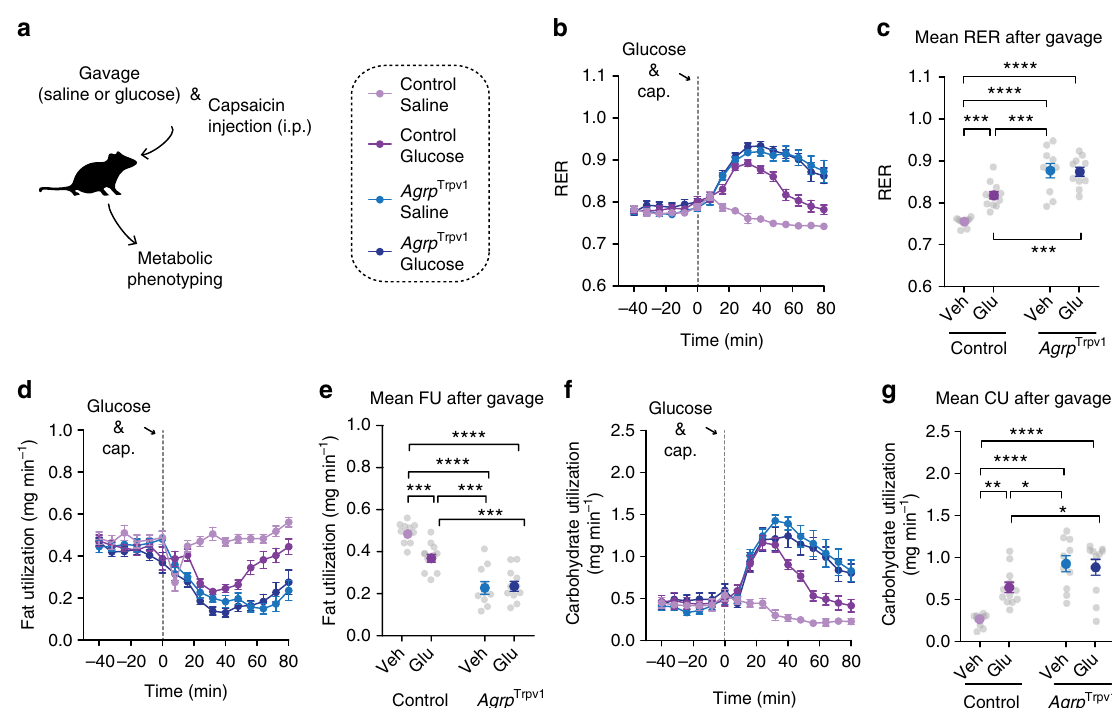
Fig. 2 Glucose ingestion and Agrp neurons control substrate utilization independently. a Control and Agrp Trpv1 mice received a bolus of saline or glucose (2 g kg − 1 ) via gavage followed by peripheral injection of capsaicin (10 mg kg − 1 , intraperitoneal (i.p.)). b Respiratory exchange ratio (RER). c Mean RER after gavage (interaction: F 1,40 = 9.82, P = 0.003; gavage solution: F 1,40 = 8.20, P = 0.006; genotype: F 1,40 = 71.31, P < 0.0001). d Fat utilization. e Mean fat utilization after gavage (interaction: F 1,40 = 7.91, P = 0.007; gavage solution: F 1,40 = 6.07, P = 0.01; genotype: F 1,40 = 79.82, P < 0.0001). f Carbohydrate utilization. g Mean carbohydrate utilization after gavage (interaction: F 1,40 = 8.29, P = 0.006; gavage solution: F 140 = 5.26, P = 0.02; genotype: F 1,40 = 37.44, P < 0.0001). In c , e and g statistical analysis was performed using two-way analysis of variance (ANOVA) on the mean response after gavage and capsaicin injection; genotype (control vs. Agrp Trpv1 ) and gavage infusion (saline vs. glucose) were used as factors for the ANOVA. Holm – Sidak ’ s multiple comparisons test (MCT) was used to fi nd post hoc differences among groups. MCTs are indicated as * P < 0.05, ** P < 0.01, *** P < 0.001 and **** P < 0.0001 in fi gure panels. Control mice + saline gavage ( n = 11); control mice + glucose gavage ( n = 12); Agrp Trpv1 mice + saline gavage ( n = 10); Agrp Trpv1 mice + glucose gavage ( n = 11). Dashed gray line indicates time of oral gavage and capsaicin